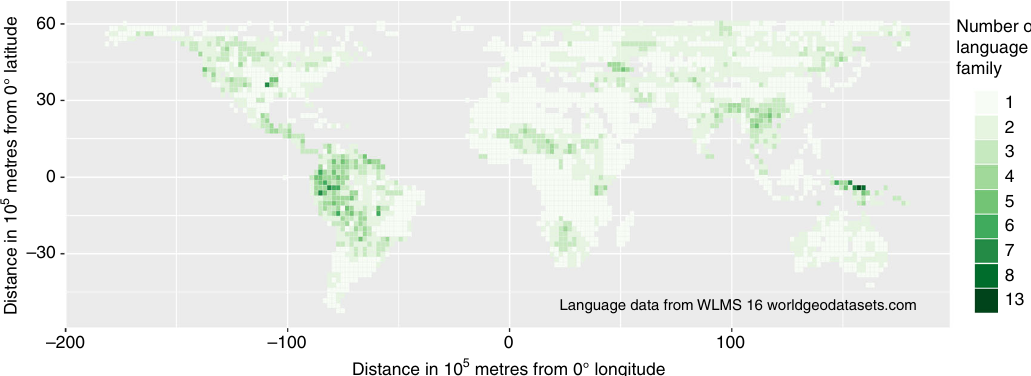
Fig. 4 Global distribution of the number of language families. Numbers of language families are shown for 200 × 200 km cells of an equal-area grid. Language family is de fi ned by the World Language Mapping System taxonomy 1 . Language isolates are treated as distinct families. Number of language families within a grid cell is calculated as the number of language families that include at least one language distributed in the grid cell. The fi gure only shows grid cells for which we have relevant